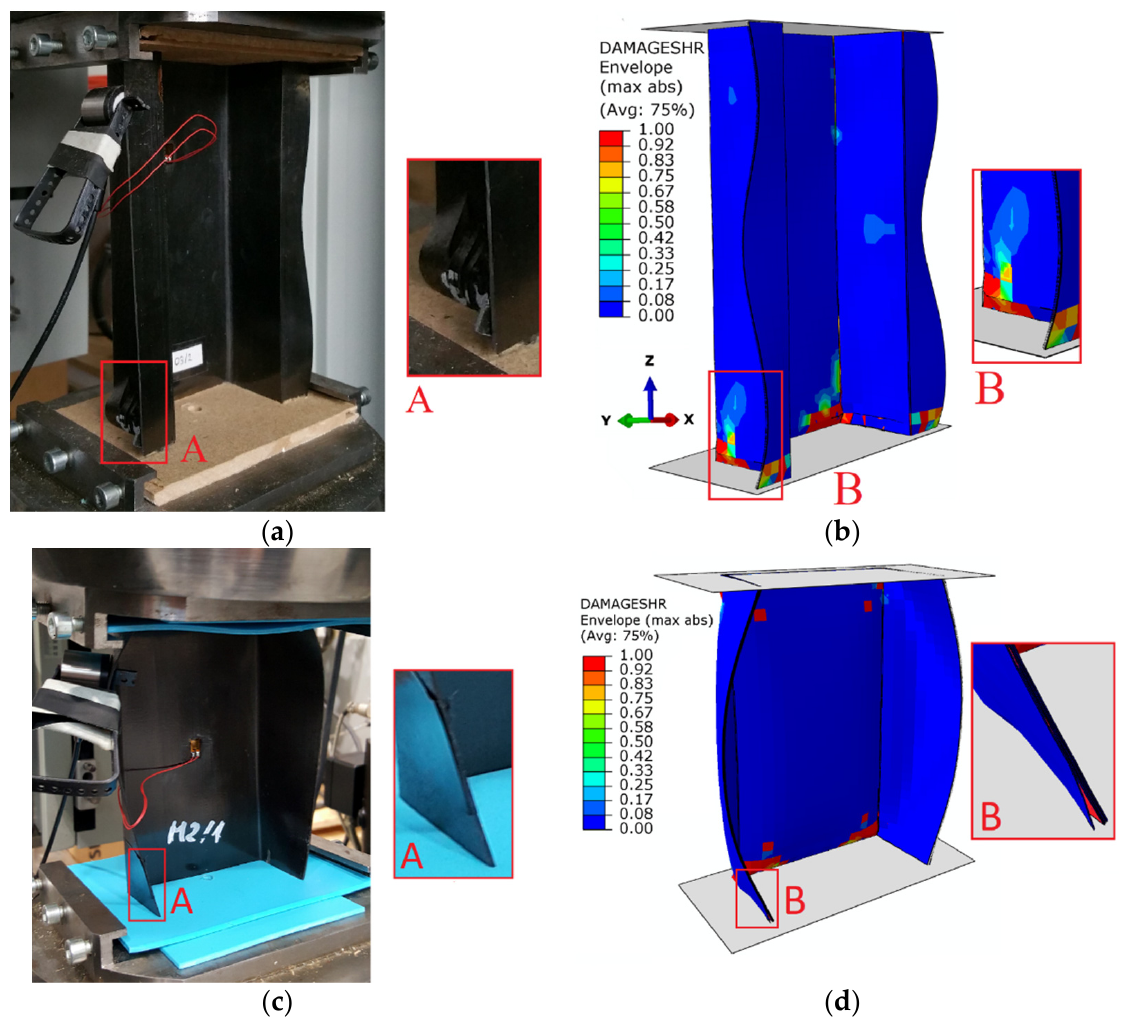
Figure 9. Comparison of failure form: ( a ) EXP of top-hat column, ( b ) FEM of top-hat column, ( c ) EXP of channel column, ( d ) FEM of channel column.